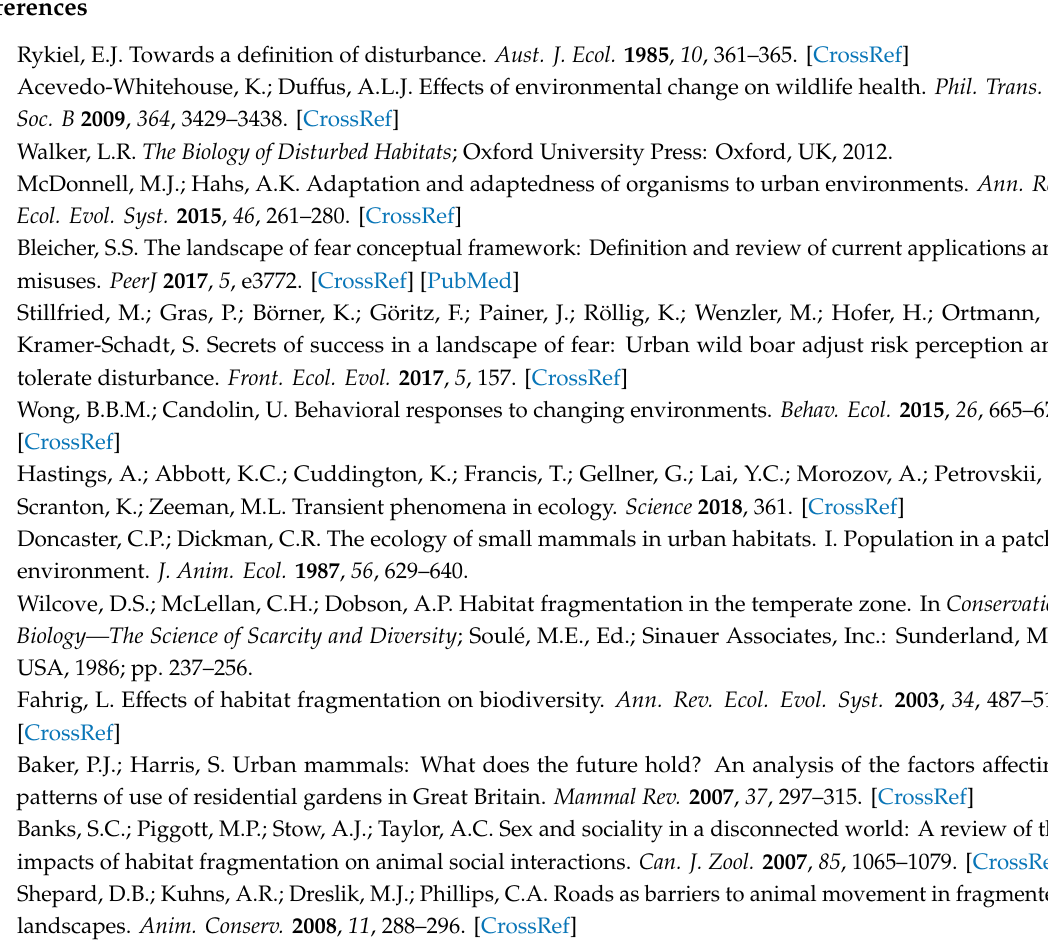
Figure S1: Mean kde95 and confidence intervals measured per treatment and sex. Figure S2: Map of GPS locations of a female (2016_17, yellow dots = locations with inactive behaviour, red dots = locations with active behaviour) and a male (2016_01, light blue dots = locations with inactive behaviour, dark blue dots = locations with active behaviour) hedgehog in the study area Treptower Park. Figure S3: Map of GPS locations of a female (2017_20), a male measured in 2017 (2017_30), and a male measured in 2018 (2018_30) in the study area Tierpark. Table S1: Overview of the study animals and data collected per animal. Table S2: Overview of mean yearly weather data (source: https: // www.wetteronline.de / ). Table S3: Overview of model results. All GPS and ACC data are available through the Movebank platform (www.movebank.org) by contacting the